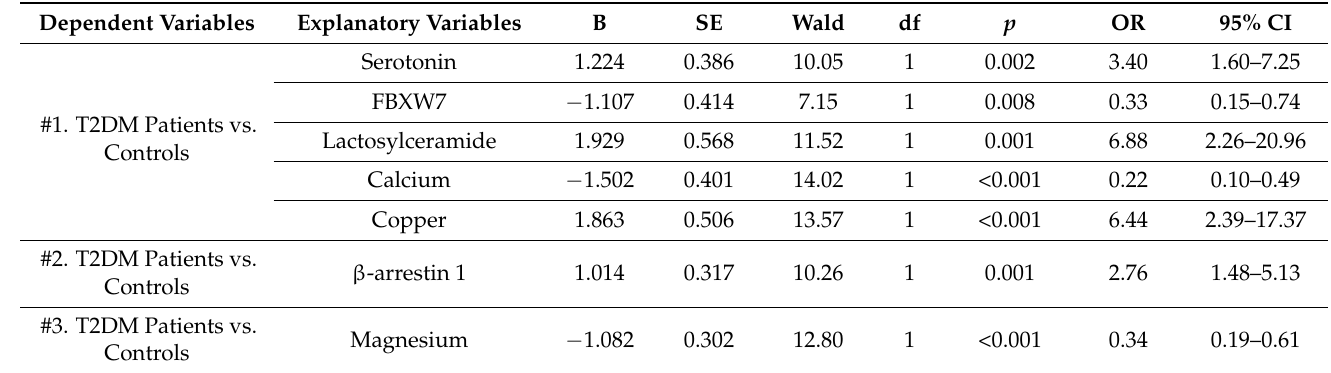
Table 5. Results of binary logistic regression analysis with T2DM as dependent variable and biomark- ers as explanatory variables.